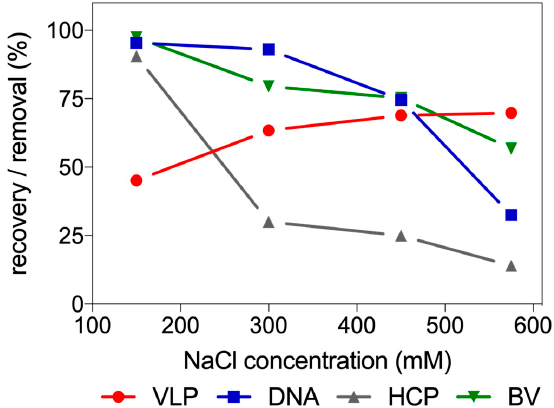
Figure 3. Batch adsorption study using Fractogel ® TMAE at different load conditions. Evaluation